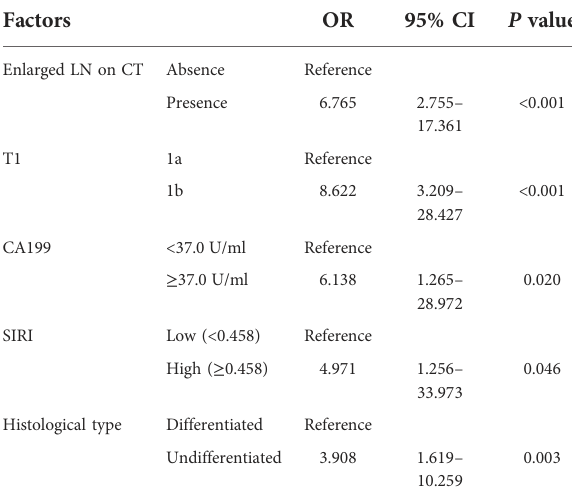
TABLE 2 Multivariate analysis of preoperative clinicopathological factors associated with